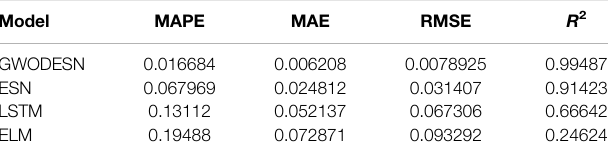
TABLE 2 | Prediction performance comparison for NARMA Model MAPE MAE RMSE R 2 GWODESN 0.016684 0.006208